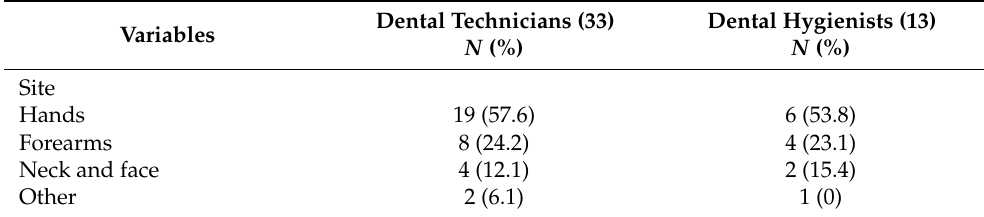
Table 1. Localization of allergic contact dermatitis skin manifestations in dental technician and dental hygienist groups.